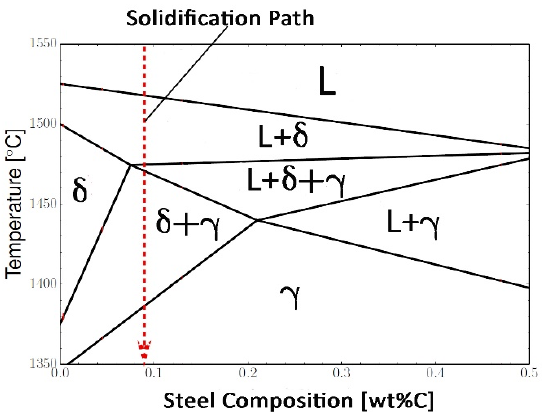
Figure 1. Pseudo-binary iron-carbon phase diagram with solidification path for 0.09 wt%C low carbon steel grade.